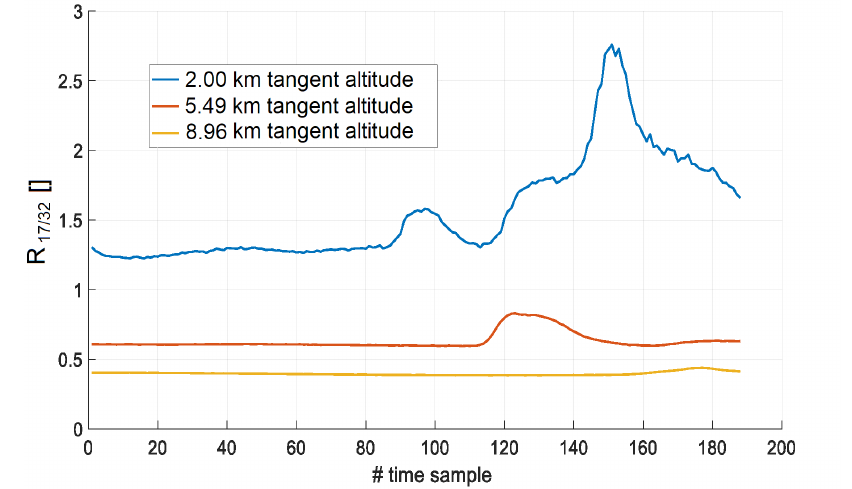
Figure 10. Time sequence of the R 17/32